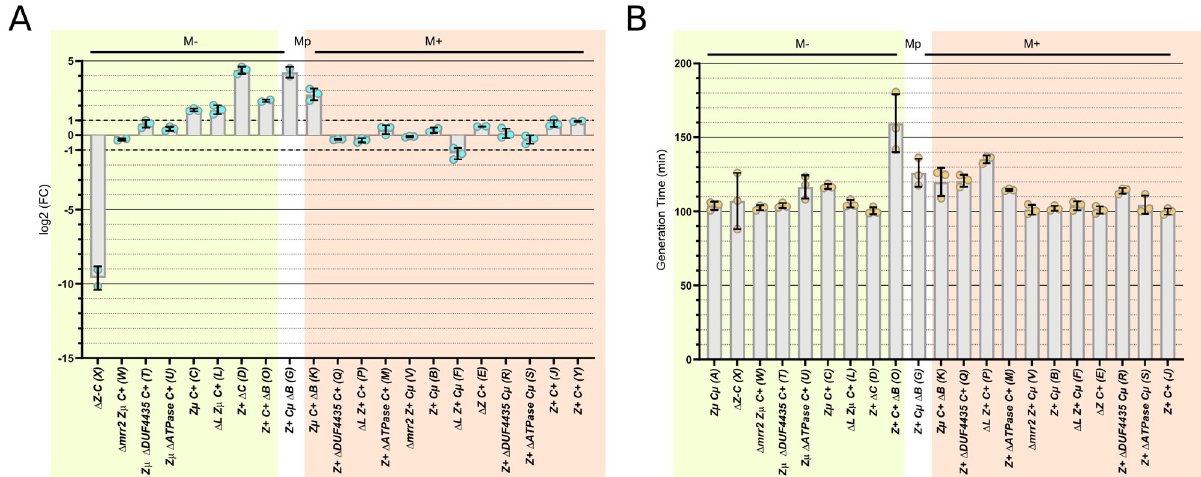
Fig 4. pglX transcript, M phenotype and growth rate responses to engineering. The X axis is common to Panels A and B, giving strain genotypes as in Table 1 (strains X and Y are not present in Panel B). Strains are grouped by M phenotype: green, M - < 6% of StySA sites are modified; white, M p 46% modified; orange, M + > 83% modified. Panel A, qPCR measure of relative pglX transcript levels compared to the ancestor, strain A (log2fold change); a two-fold change is considered significant, indicated by the dotted lines at 1 and -1. Each blue dot shows relative transcript level for one biological replicate; bars display the mean for each strain. Panel B, generation time in minutes. Each orange dot represents a biological replicate; bars display the mean for the strain.